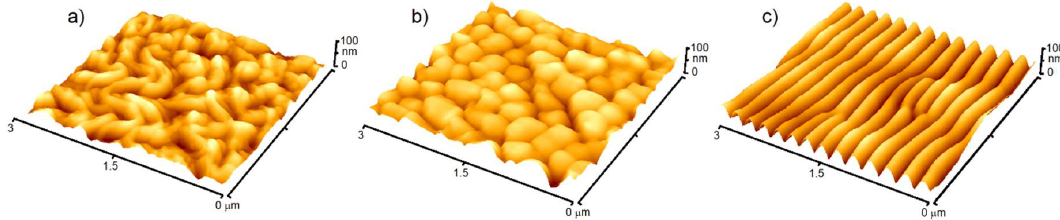
Figure 1. Various surface nanostructures onto polyethylene terephthalate induced by KrF excimer laser irradiation, ( a ) worm-like, ( b ) globular and ( c ) ripple structures. Measurements were carried out by atomic force microscopy.